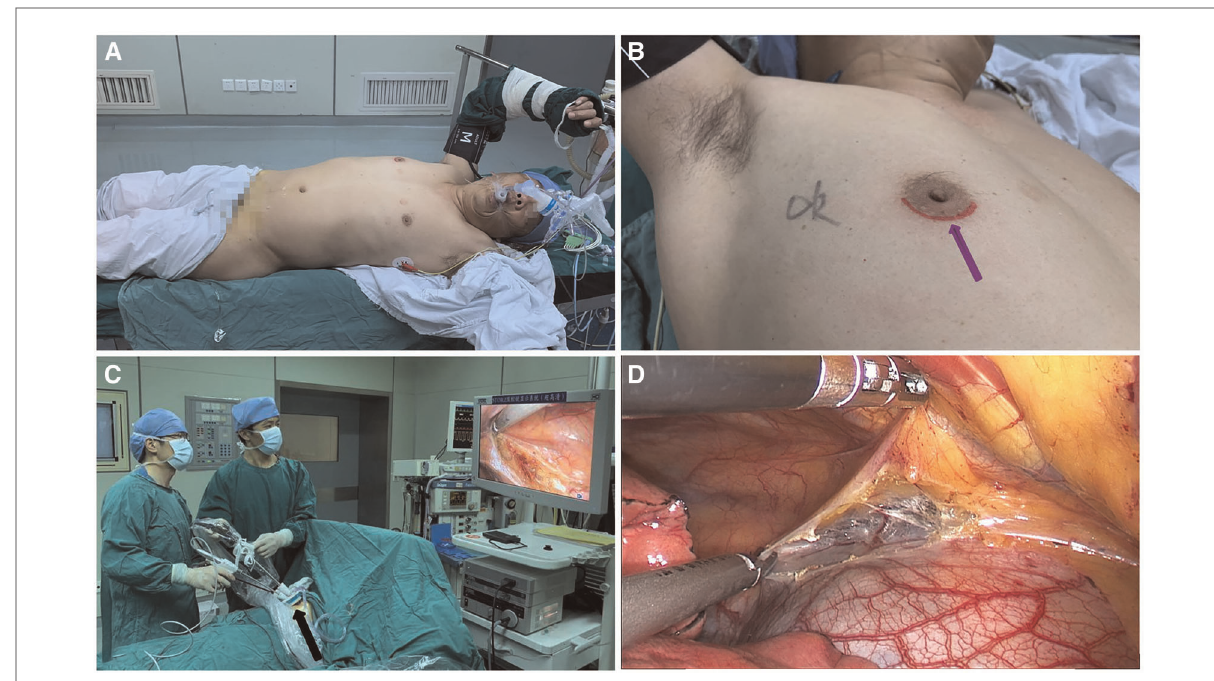
FIGURE 1 ( A ) the patient was placed in the left lateral decubitus position at 45° during surgery. ( B ) Transareolar uniportal incision was marked before the operation. The purple arrow indicates the lower edge of the areola. ( C ) Procedure of transareolar uniportal thoracoscopic extended thymectomy for patients with myasthenia gravis. ( D ) Transareolar uniportal endoscopic view of the right thoracic